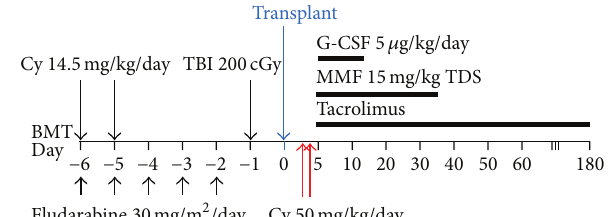
Figure 1: Conditioning regimen used for nonmyeloablative haplo- identical transplantation, using high dose cyclophosphamide (Cy) posttransplant for in vitro T cell depletion. Pretransplant condition- ing involved Cy, fludarabine, and TBI, with administration of high dose Cy on day 3 (or days 3 and 4) after transplantation. GVHD prophylaxis consisting of tacrolimus and MMF was initiated after Cy. BMT: bone marrow transplantation, Cy: cyclophosphamide, TBI: total body irradiation, G-CSF: granulocyte colony stimulating factor, and MMF: mycophenolate